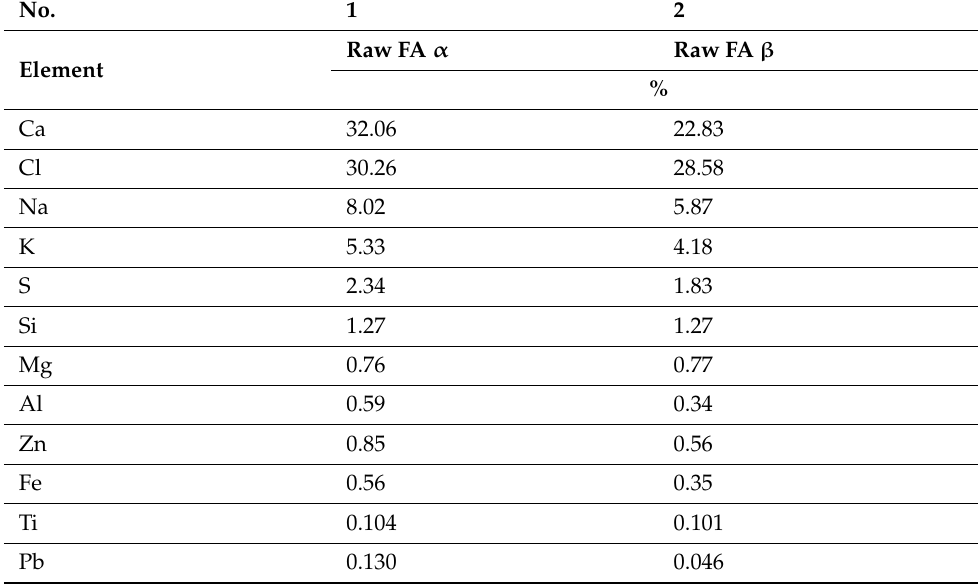
Table 1. XRF results of raw fly